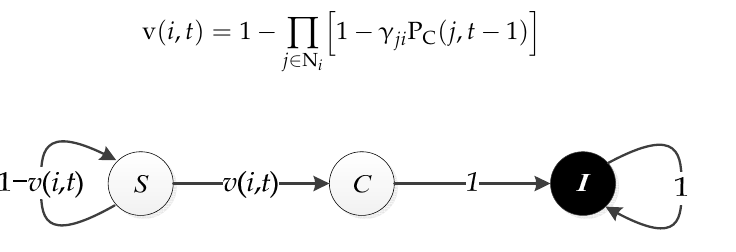
Figure 2. The state transition graph of a sensor node in worm propagation.